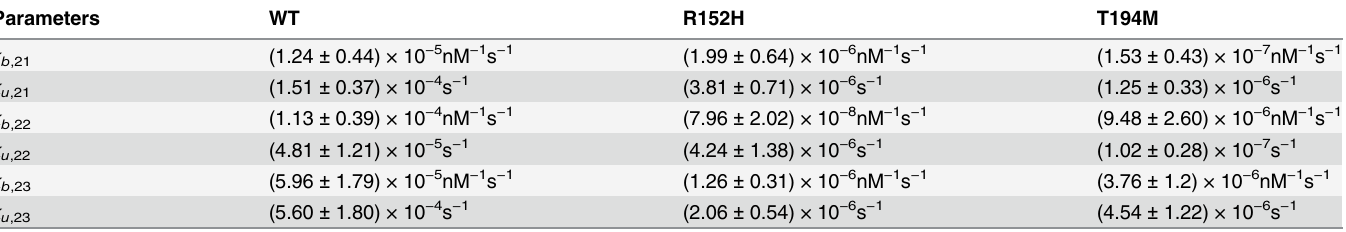
Table 4. List of optimized parameters used for the simulation of in vitro transcription assay of fhaB . Here, x ± y stand for the value of optimized param- eter x with standard deviation y . The standard deviation is calculated using the data of 500 independent SA runs. Parameters